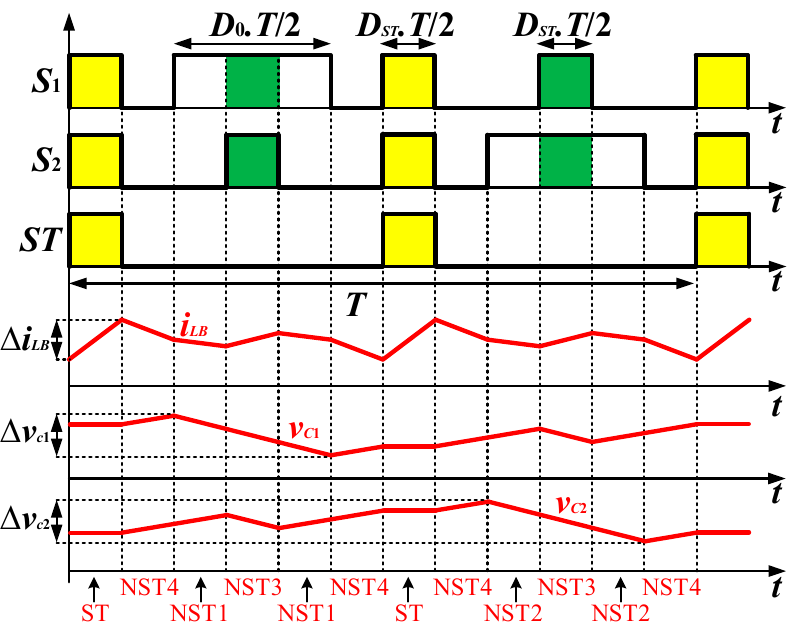
Figure 4. The key waveform in switching period.